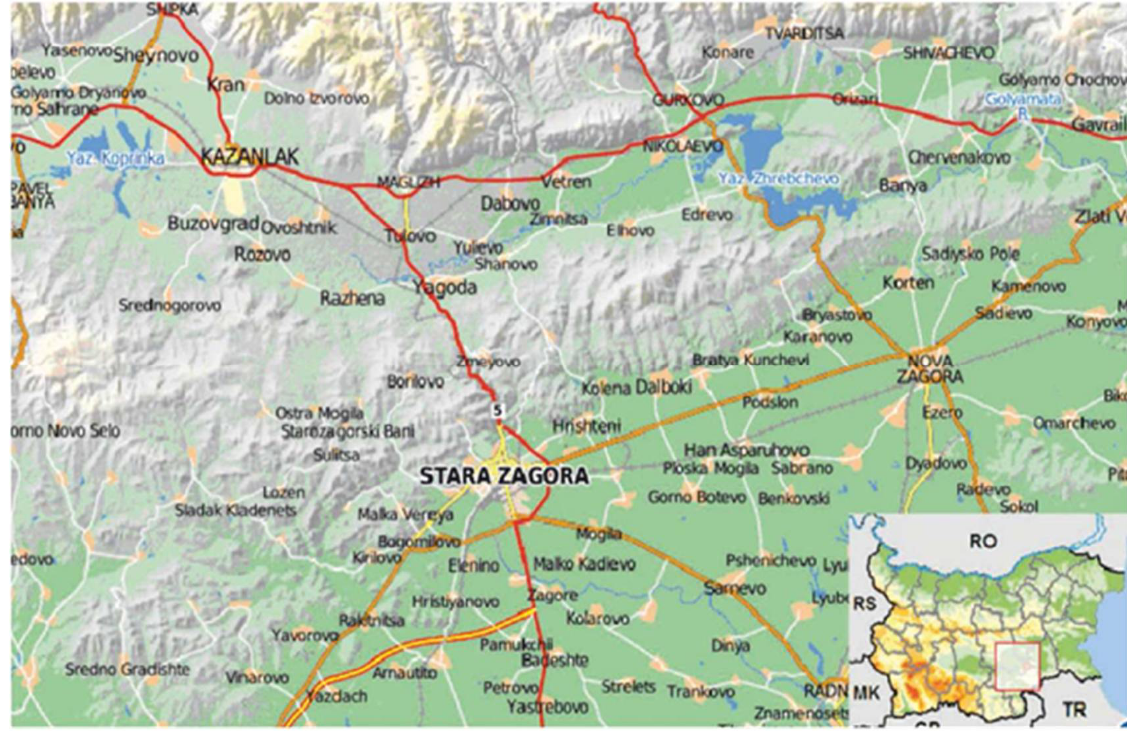
Figure 1. Map of Stara Zagora region, Bulgaria.